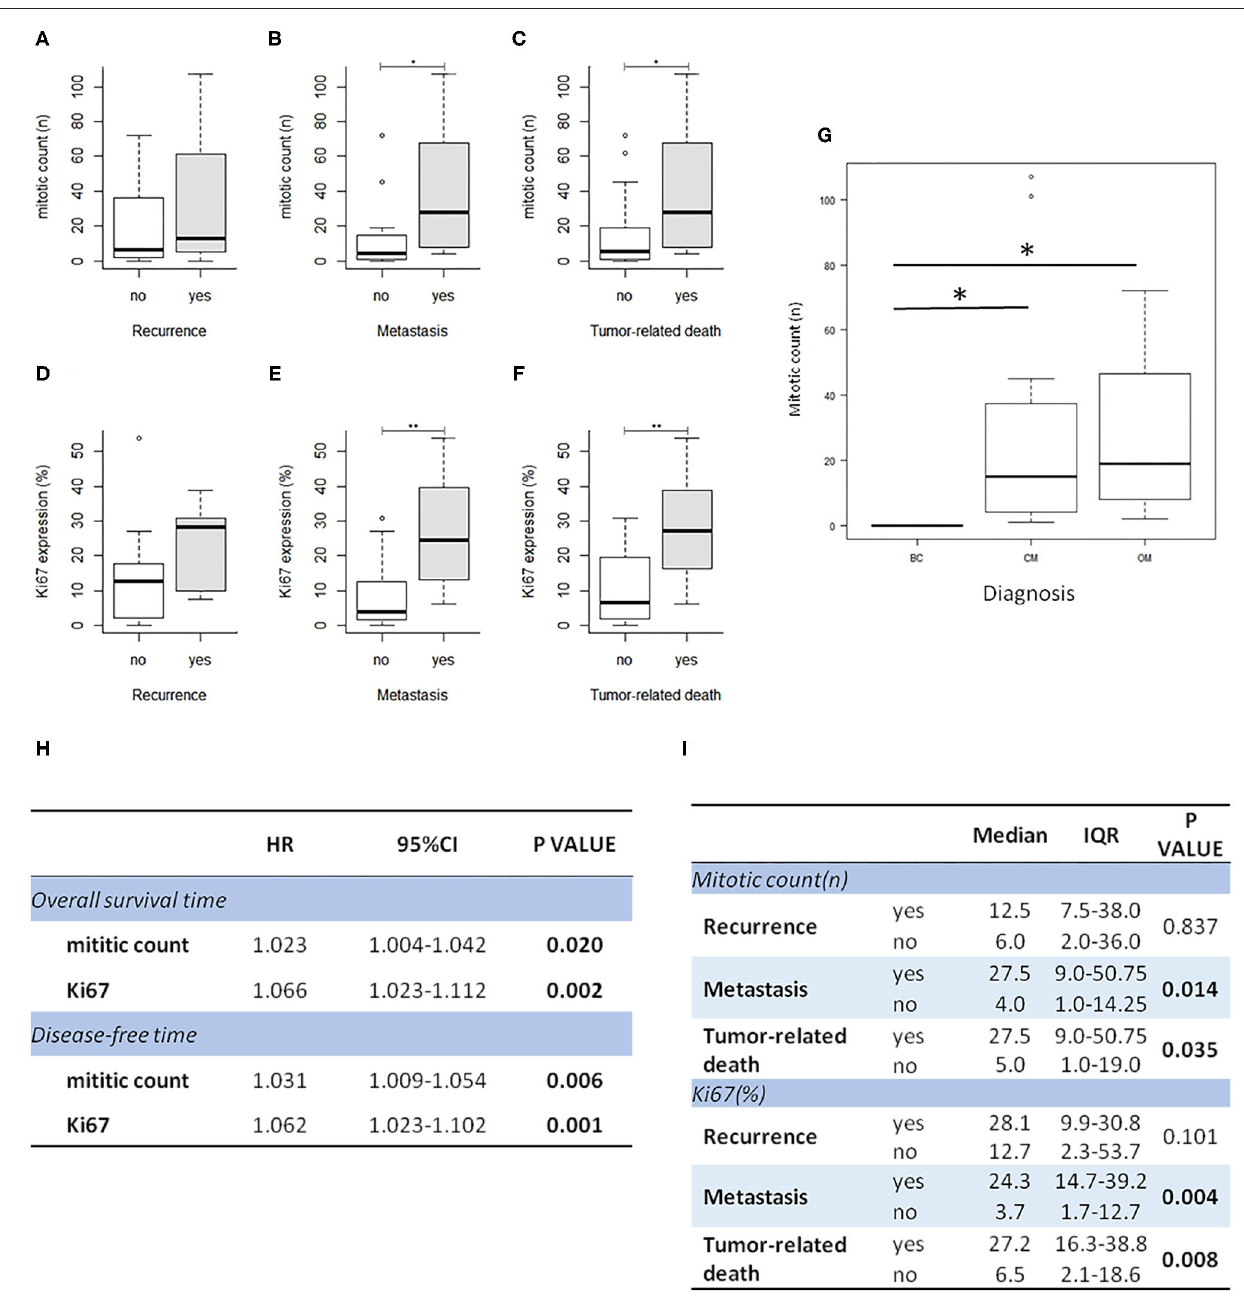
FIGURE 2 | Mitotic count and Ki67 index are higher in melanoma cases with recurrence, metastasis, and unfavorable outcome. Correlation of Ki67 index and mitotic count with clinical follow up data (A–F) ; correlation of mitotic count with diagnosis (BC, benign cutaneous melanoma; CM, cutaneous malignant melanoma; OM, oral melanoma); * P < 0.05 (G). (H) The table shows the results of survival analysis of mitotic count and Ki67 (Cox proportional regression analysis; HR: hazard ratio). (I) the table shows the association between mitotic count and Ki67 expression with clinical data (IQR: interquartile